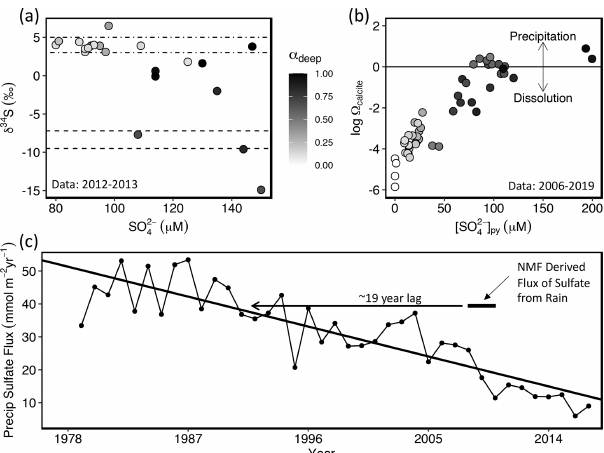
Figure 4. (a) Sulfur isotope composition plotted versus concentra- tion for sulfate in the subset of stream water or groundwater sam- ples at Shale Hills where S isotopes were measured (symbols; Jin et al., 2014). Dot-dashed lines represent the average sulfur isotope range for acid rain in the USA (3%–5‰; Bailey et al., 2004) and dashed lines represent the average sulfur isotope range of pyrite cal- culated from NMF results ( − 9.5‰ to − 7.2‰). Sulfur isotopes in pyrite at Shale Hills were previously constrained to lie in the range of − 1‰ to − 15‰ (Jin et al., 2014). (B) Plot showing the cal- cite saturation index (log (cid:127) calcite ) versus concentration of pyrite- derived sulfate (calculated through NMF) in surface and ground- water samples at Shale Hills where alkalinity was measured. Here (cid:127) calcite ( = ion activity product/equilibrium constant for calcite dis- solution) is < 1, the water is undersaturated with respect to calcite, and when (cid:127) calcite is > 1, the water is oversaturated. Black line rep- resents water–calcite equilibrium. Some samples in (b) differ from those in (a) because more samples were collected for alkalinity than sulfur isotopes. In both A and B, color shading represents the frac- tion of total sulfate derived from pyrite calculated by NMF (i.e., α deep ). (c) Time series plot showing the flux of sulfate in Pennsyl- vania NADP site PA42 (2.8km from Shale Hills) from wet and dry deposition (see Sect. S2.4). Black bar shows the NMF results for the export flux of sulfate derived from acid rain for Shale Hills during our sampling period and the rationale for the inferred 19-year lag between input and